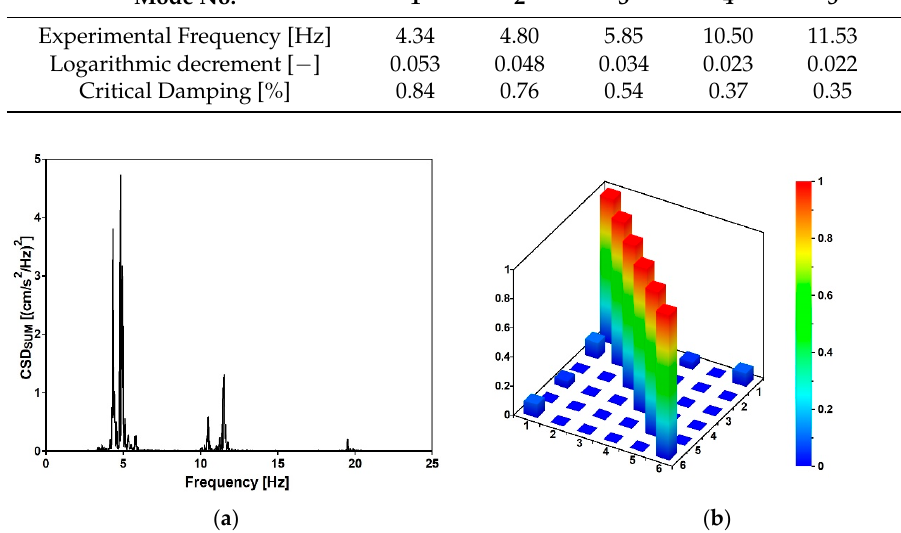
Table 3. Experimentally detected natural frequencies and logarithmic decrements of damping. Mode No.